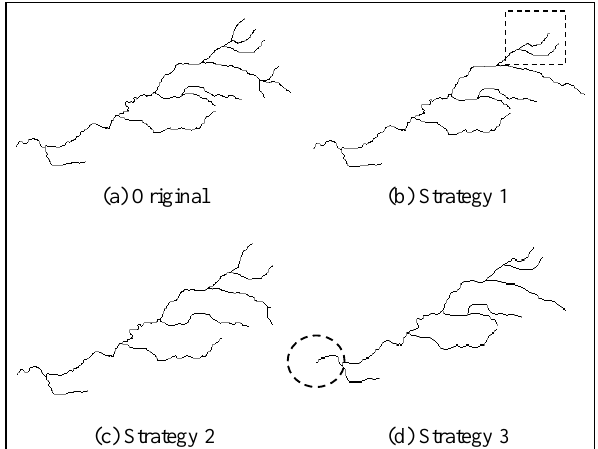
Figure 8 Generalised river network for parallel case